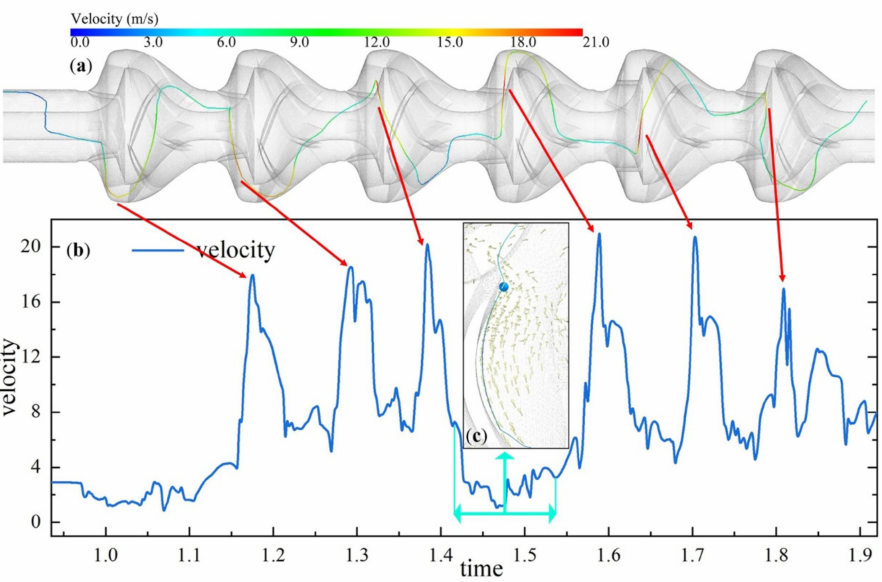
Figure 14. ( a ) Particle trajectory of a representative particle; ( b ) Velocity of the particle; ( c ) Partial zoom of particle